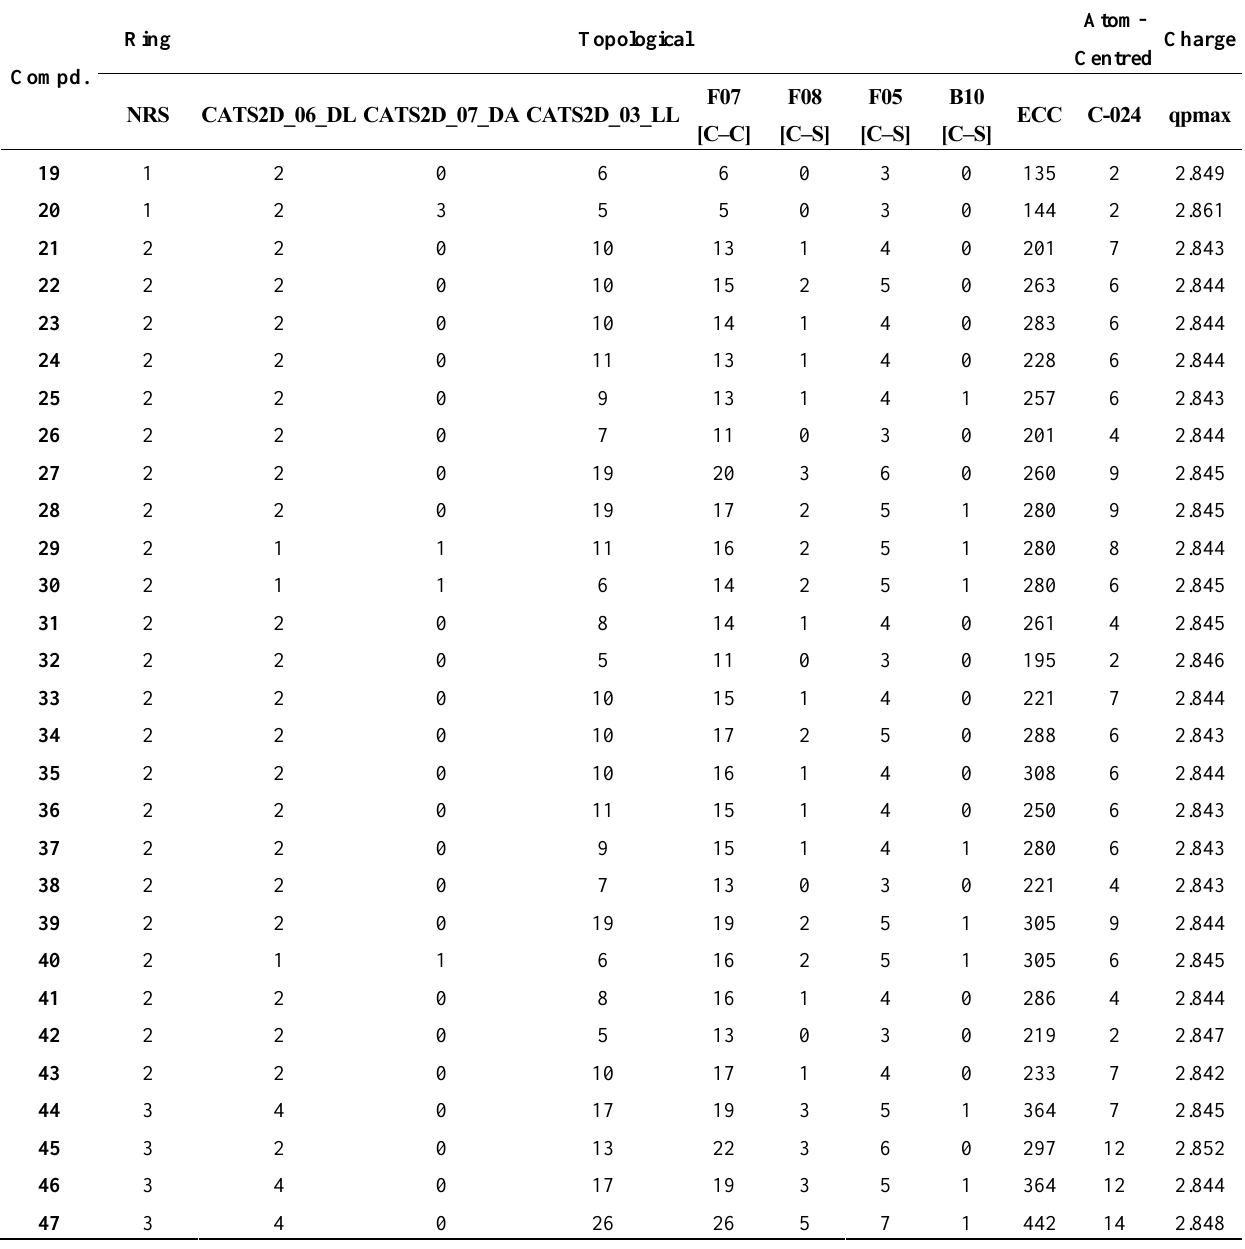
Table 6. Molecular descriptors (ring, topological, charge descriptors and atom-centred fragments) calculated by Dragon (Talete, Milano, Italy, version